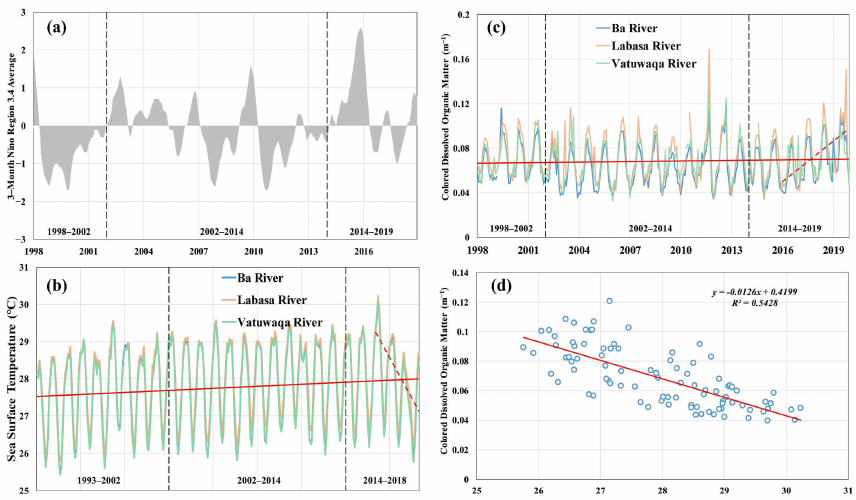
Figure 7. Ocean El Niño index, sea-surface temperature, colored dissolved organic matter changes, and correlation analysis of two kinds of ocean environmental parameters. ( a ) Ocean El Niño index; ( b ) Sea-surface temperature; ( c ) Colored dissolved organic matter ( d ) Correlation analysis between sea-surface temperature and colored dissolved organic matter (the Ocean El Niño Index (ONI) in ( a ) is the average sea-temperature anomaly in the Nino 3.4 area for three consecutive months. The threshold is subdivided into weak (0.5–0.9), medium (1.0–1.4), and strong (1.5–1.9) Harmony is very strong ( ≥ 2.0), and the data come from the Climate Forecast Center of the National Meteorological Administration (website: https://origin.cpc.ncep.noaa.gov/ (accessed on 4 September 2021)). The data of sea surface temperature and colored dissolved organic matter are from 2016 to 2018 in ( b , c